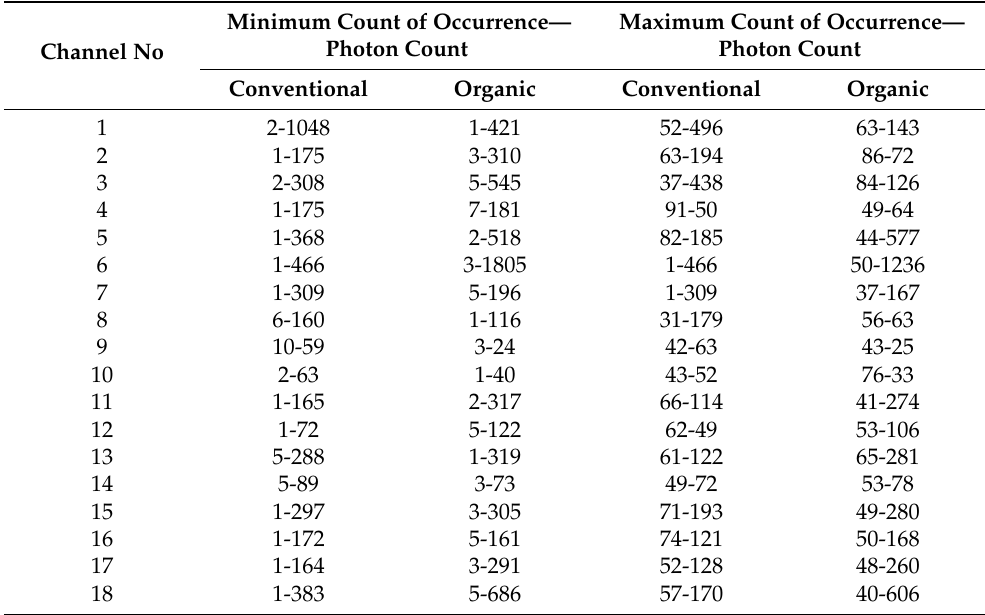
Figure 6. ( a ) Histogram of photon count for conventional Green chili; ( b ) histogram of photon count for organic green chili. Table 6 records a 1048 photon count value for a minimum count of 2 times from Channel 1 for conventional chili. A photon count value of 421 is recorded for a single count of occurrence of organic chili. Table 6. Eighteen-channel photon count distribution and the number of occurrences for conventional and organic green